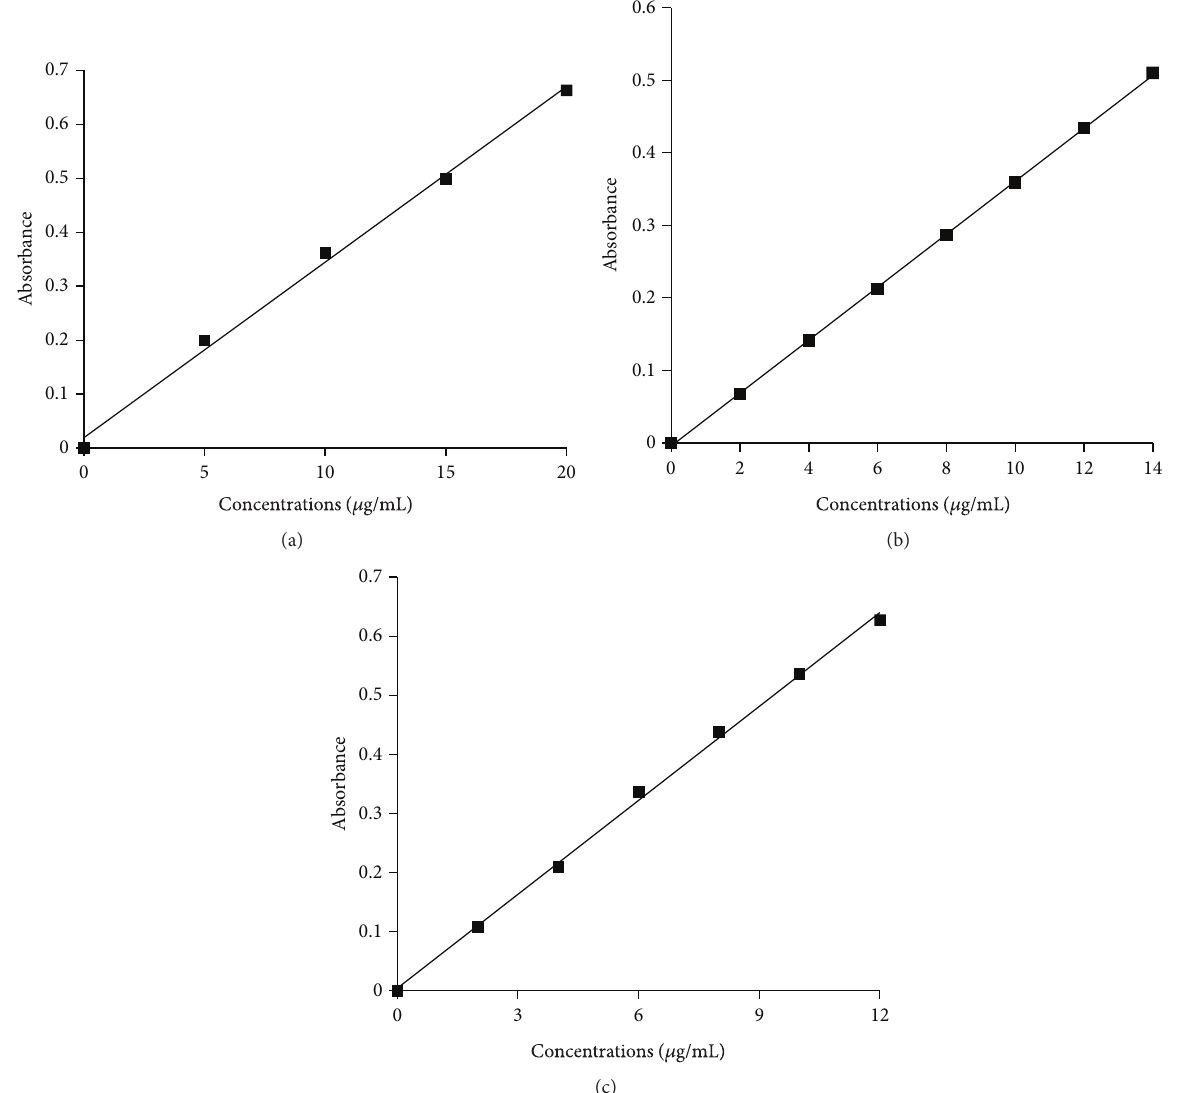
(c) F 4: Calibration curves for (a) method A, (b) method B, and (c) method C.